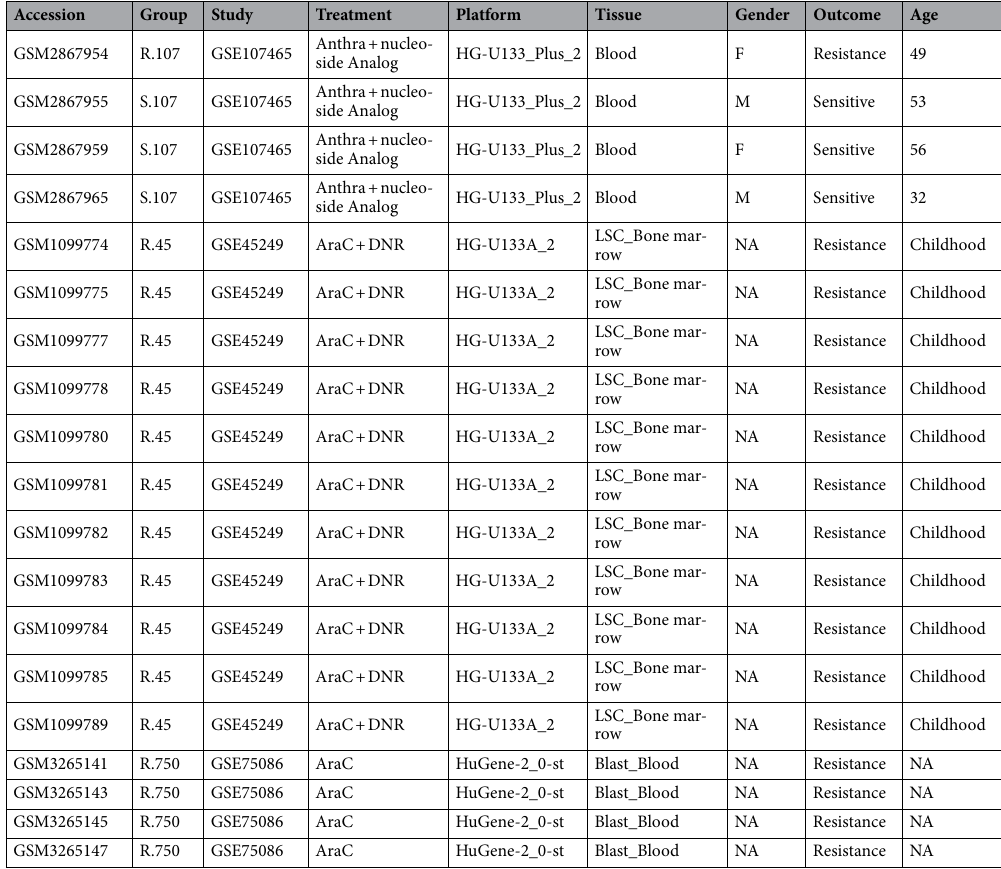
Table 2. Characteristics of the samples used in the meta-analysis. Anthra Anthracycline, DNR Daunorubicin, AraC Cytarabine, NA not available.